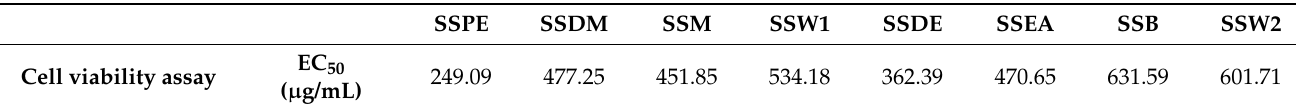
Table 4. Cytotoxic potency of SS extracts in SH-SY5Y cells in terms of half-maximal effective con- centrations. EC 50 corresponds to the concentration of extract required to reduce the cell viability by 50%.